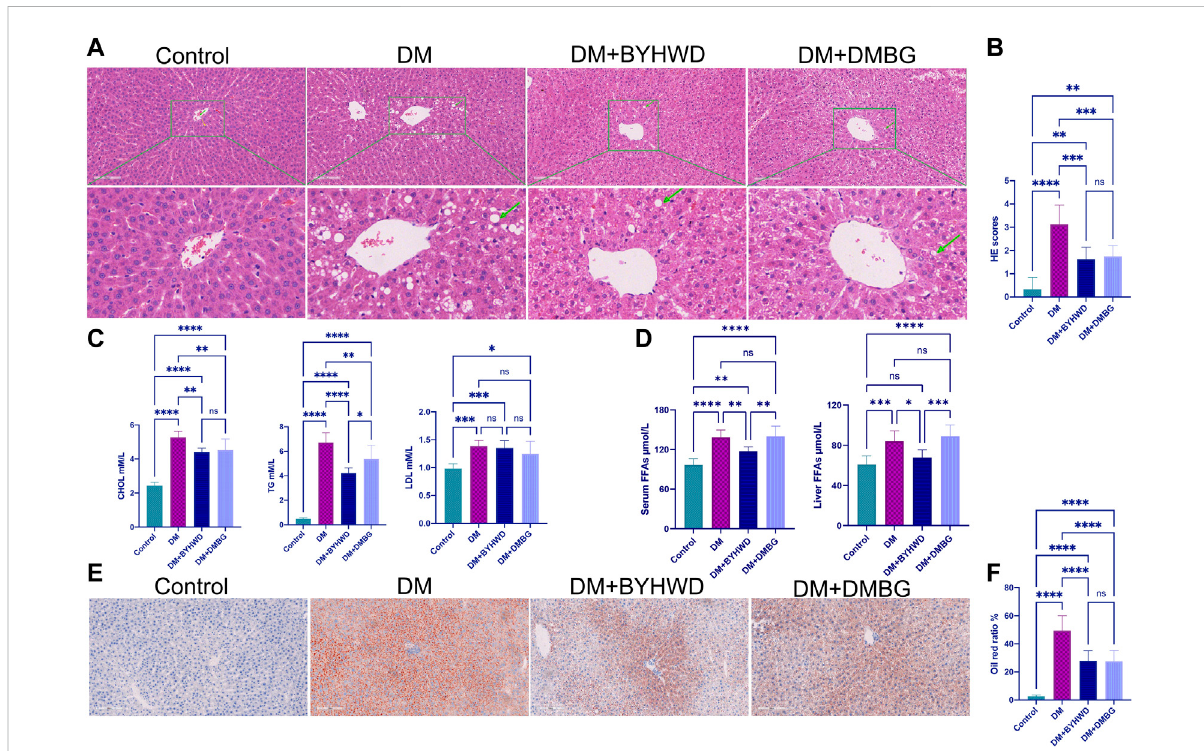
FIGURE 3 BYHWD decreased the fat accumulation in the liver and reduced the serum lipid levels: (A) representative HE images from four groups; (B) HE scores ’ comparison; (C) CHOL,TG, and LDL comparisonamongthefour groups; (D) thecomparison ofFFAsin theliverand intheserum amongthe four groups; (E) representative images of liver tissue section staining by Oil Red O; (F) the comparison of the Oil Red O ratio among the four groups. Dataareshownasmeans±S.D( n =6 – 8).Statisticalanalysiswasperformedbyone-wayANOVA,followedbyTukey ’ smultiplecomparisonstest for the false discovery rate. * p < 0.05, ** p < 0.01, *** p < 0.001, and **** p < 0.0001 were set to compare the mean of each group with the mean of every other